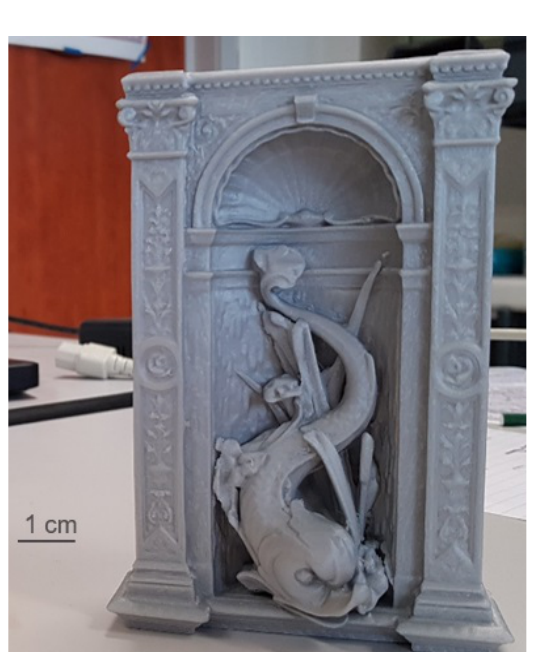
Figure 10. Example of 3D printed fish (on the left side of the